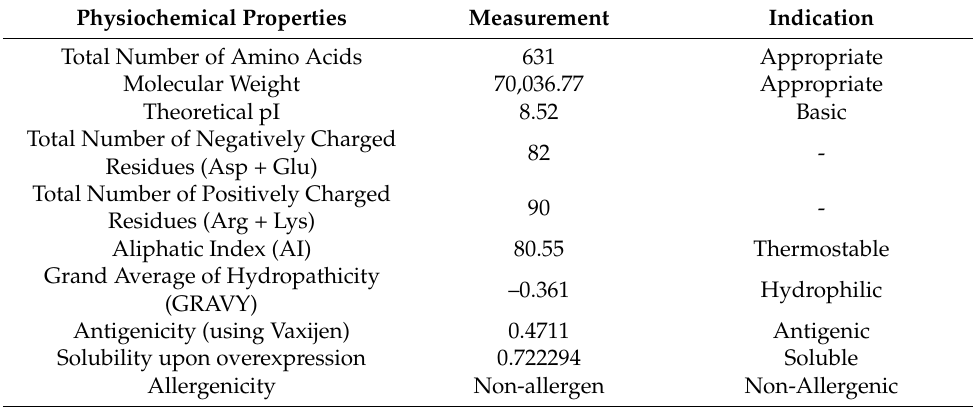
Table 4. Analysis of peptide vaccine